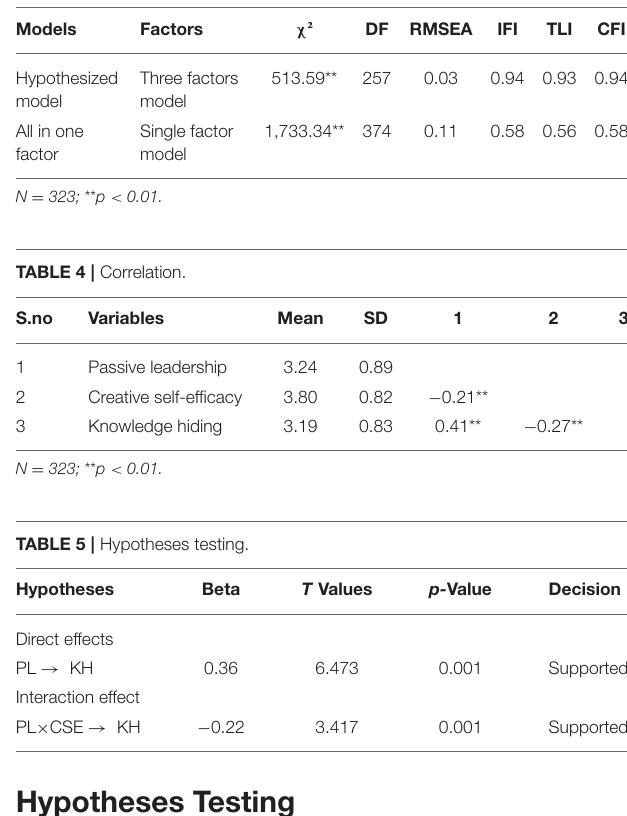
TABLE 1 | Validity and reliability of constructs.